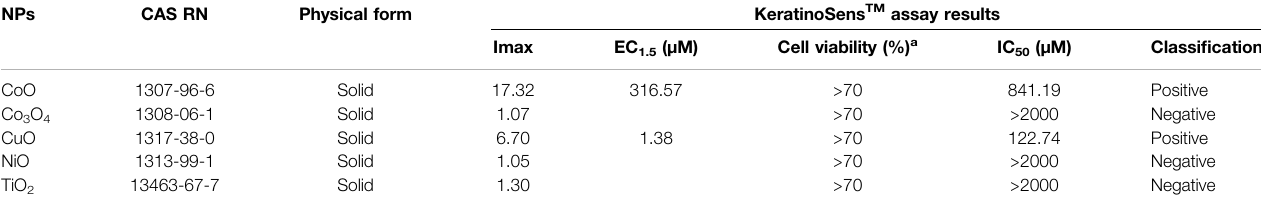
TABLE 2 | KeratinoSens TM assay results with the fi ve metal oxide NPs. NPs